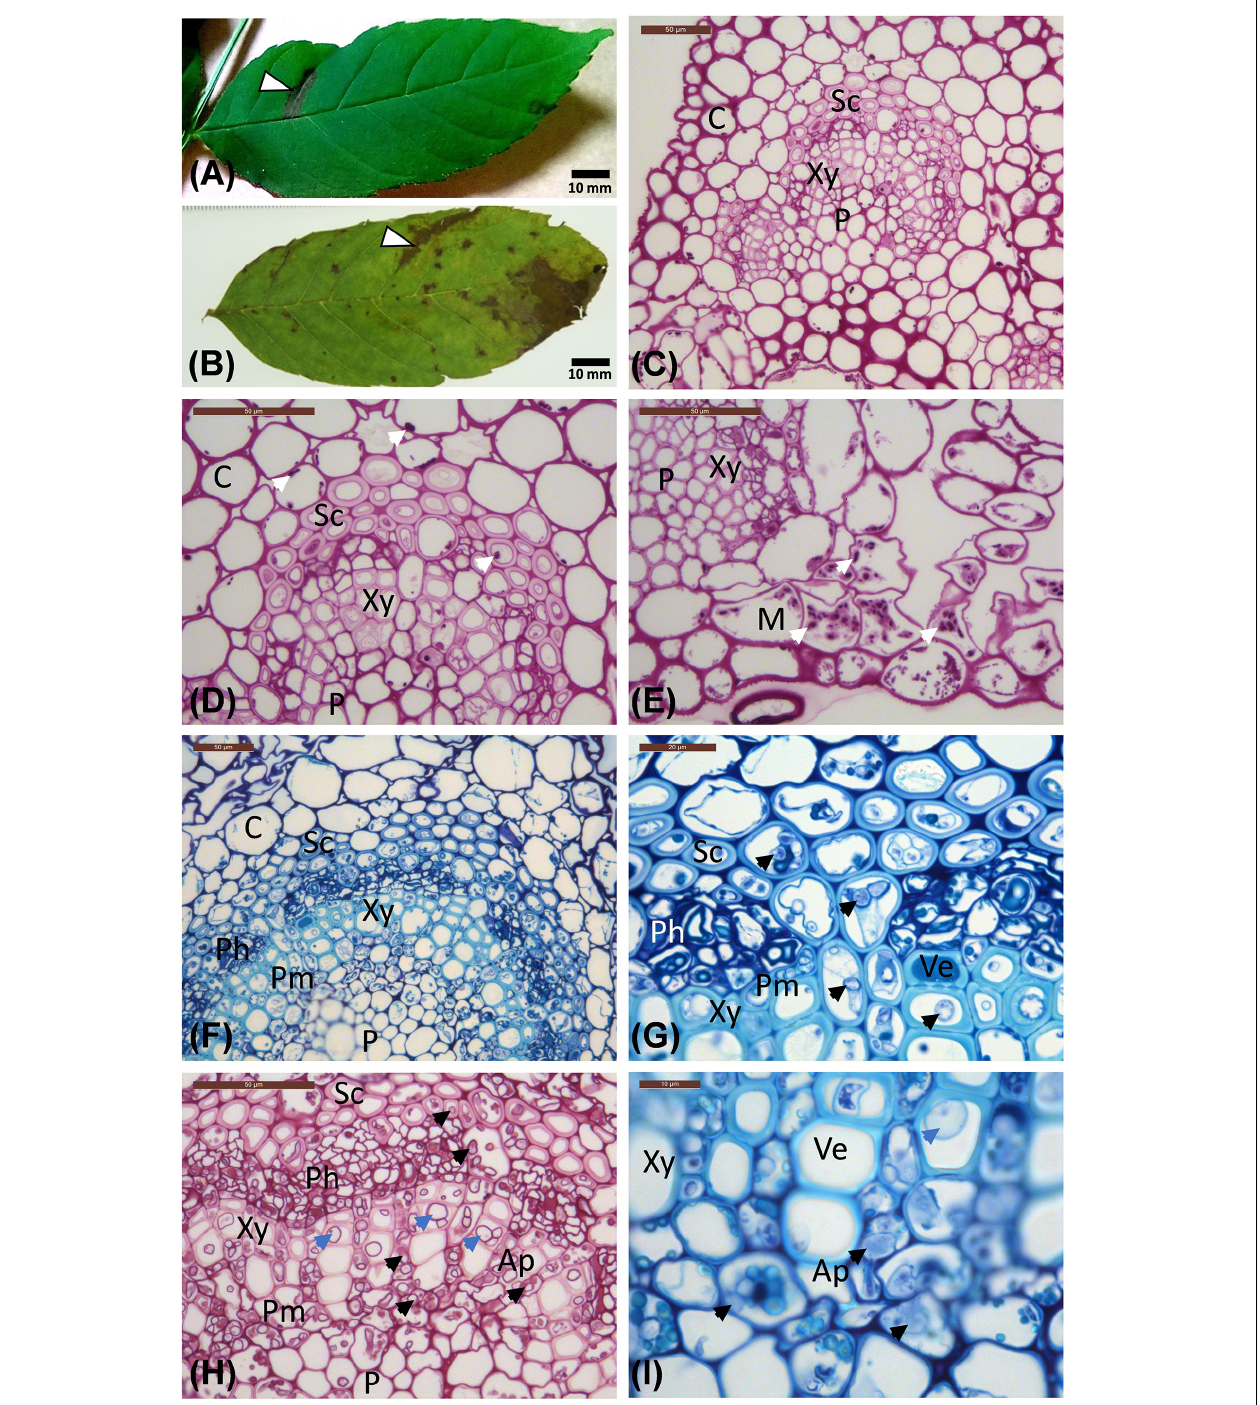
FIGURE 1 | Leaflet images and micrographs of transverse sections of leaflet veins. (A) Leaflet from the Stjørdal site, with a necrotic lesion along one side vein (arrowhead, sample S1) in an otherwise healthy appearing leaflet. (B) Leaflet from the Norderås site with a broad necrotic lesion following one side vein, and several small lesions mostly in leaf blade areas. (C–E) Transverse sections of veins from asymptomatic regions of leaflets from Stjørdal (C,D) and Norderås (E) show the organization of different cell types and the presence of some purple-red stained starch grains (white arrows). (F–I) Transverse sections of veins from lesion areas in leaflets sampled from Stjørdal (F,G) or Norderås (H,I) and showing hyphal presence in sclerenchyma, phloem, axial parenchyma, and perimedullary pith (examples pointed with black arrowheads) and formation of tyloses in vessel elements (examples pointed with blue arrowheads). Note also the appressoria-like swelling upon hyphal spread between two cells of axial parenchyma (I) . Ap, Axial parenchyma; C, Cortex; M, Mesophyll; Ph, Phloem; P, Pith; Pm, Perimedullary parenchyma; Sc, Sclerenchyma; Ve, Vessel elements; Xy, xylem.